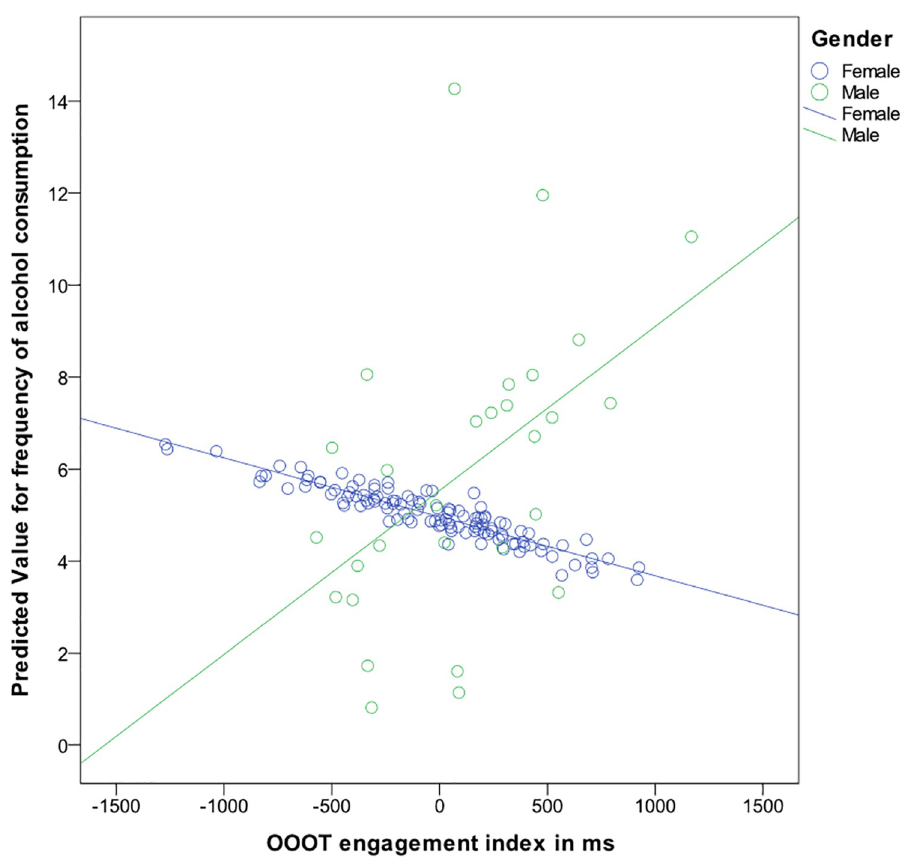
Fig 4. Frequency of alcohol consumption for males and females by attentional engagement as measured with the OOOT.